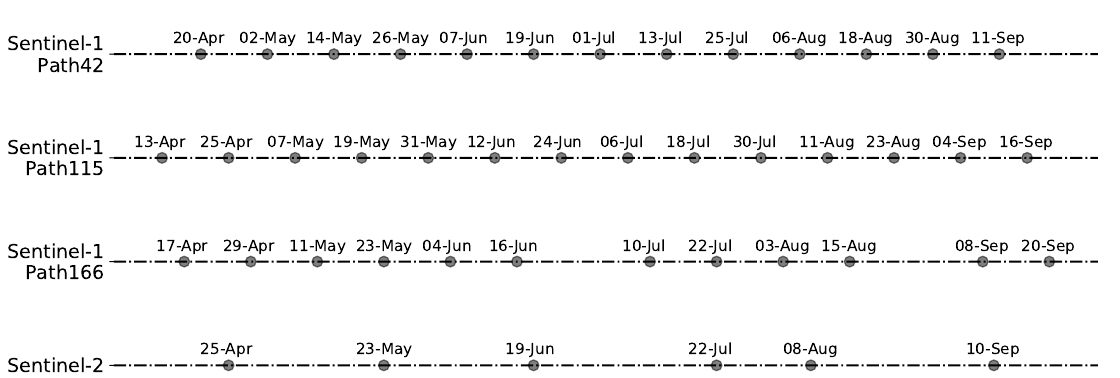
Figure 6. Acquisition timing of the Sentinel-1 and Sentinel-2 images taken during the dry season in